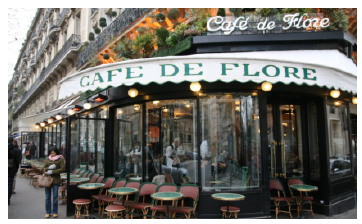
Figure 8. Café de Flore (1887, Paris, France).